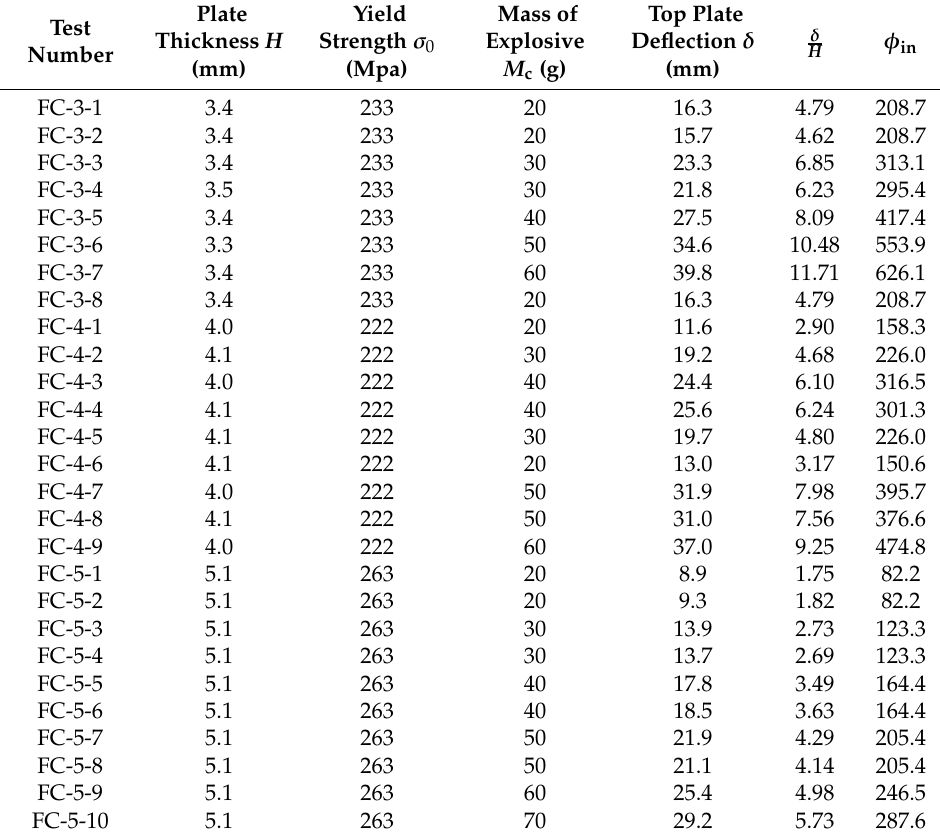
Figure 1. Illustration of the test device of the fully confined blast. Table 1. Dimensionless number and deflection for the test plates in Geretto’s confined blast tests.